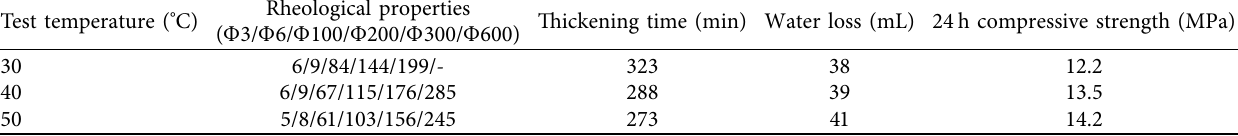
Table 12: Performance of the cement slurry system at different